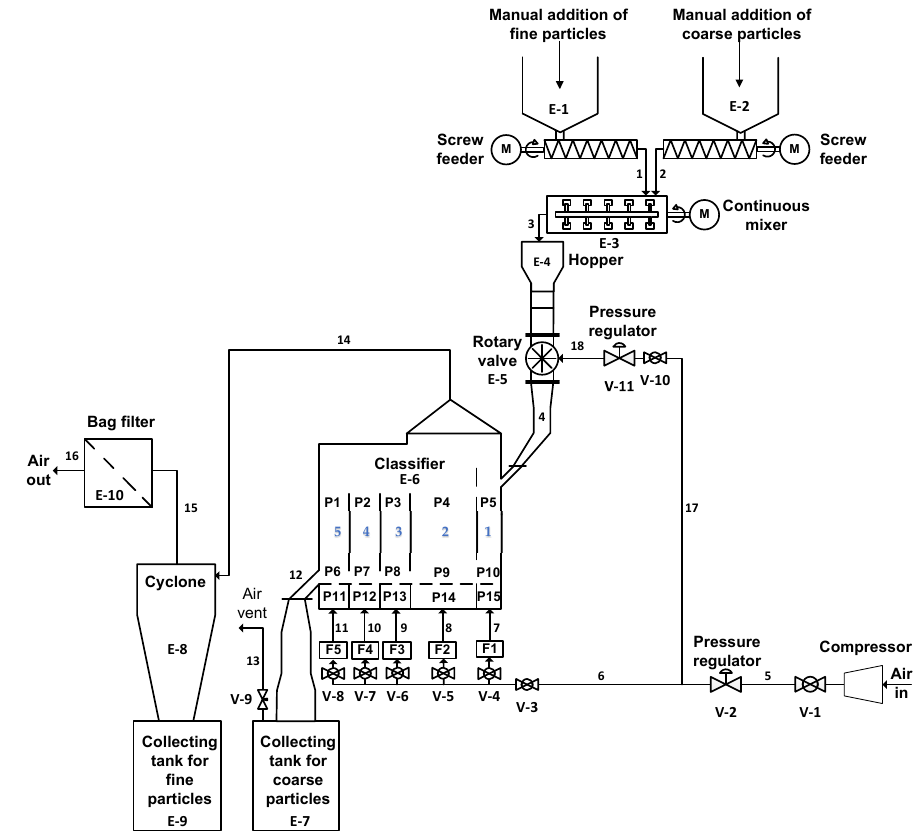
Figure 1. Cold ‐ flow lab ‐ scale classifier system. Figure 1. Cold-flow lab-scale classifier system.